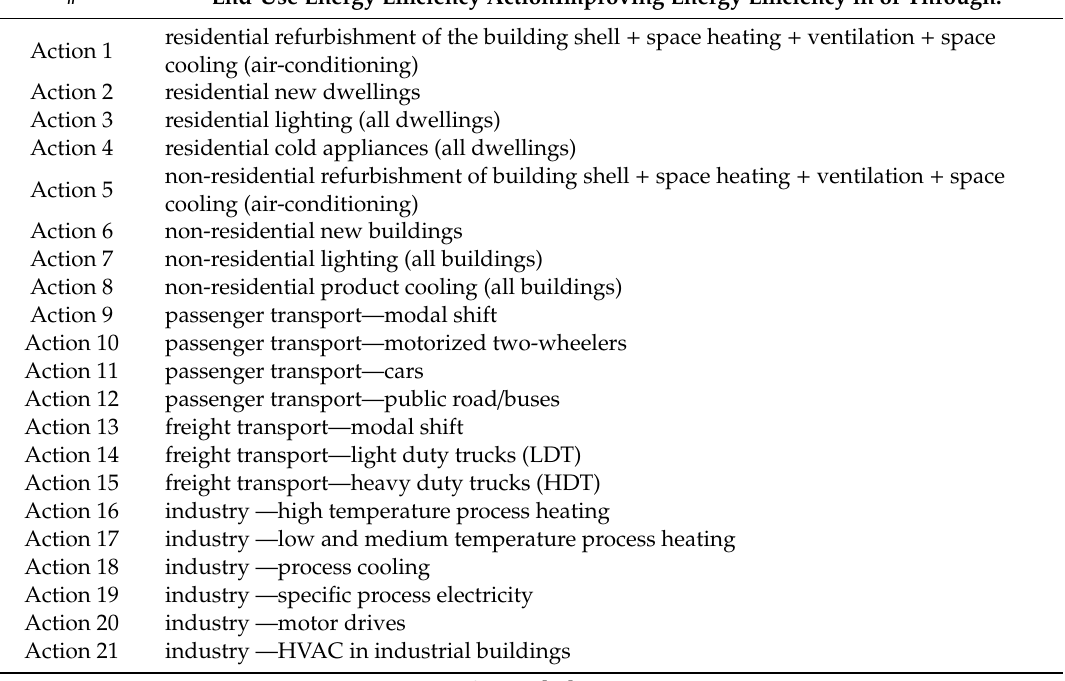
Table 1. End-use EEI actions of the COMBI